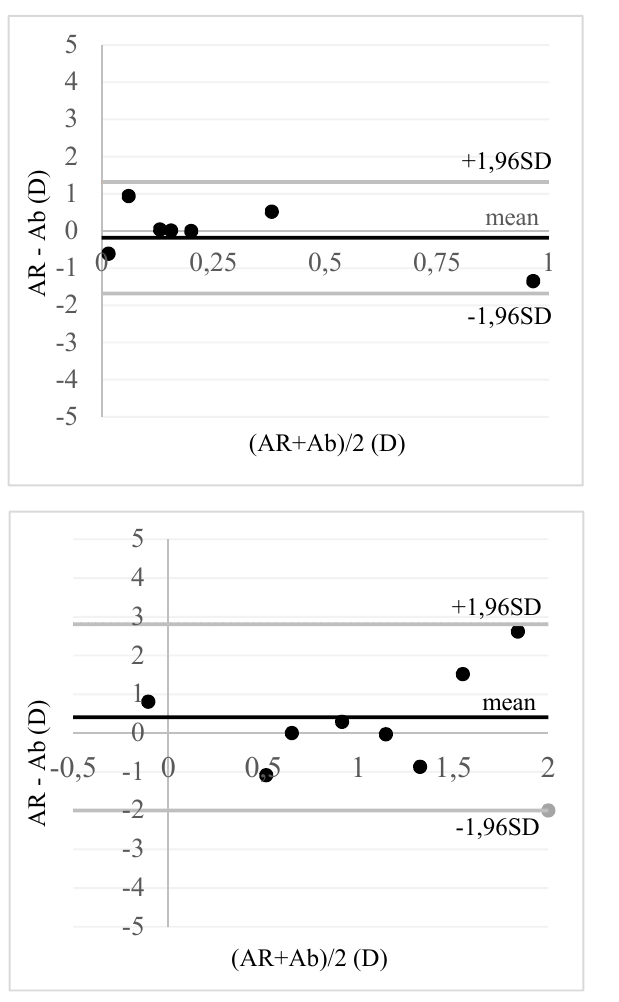
Fig. 3. Bland-Altman plot comparing the measurements of accommodative lag in the relaxed state (up) and with an accommodative stimulus of 3D (down) obtained with the open- field autorefractor (AR) and with the Shack-Hartmann aberrometer (Ab). In the x axis is represented the average of the measures of these two instruments and in the y axis the difference between them in